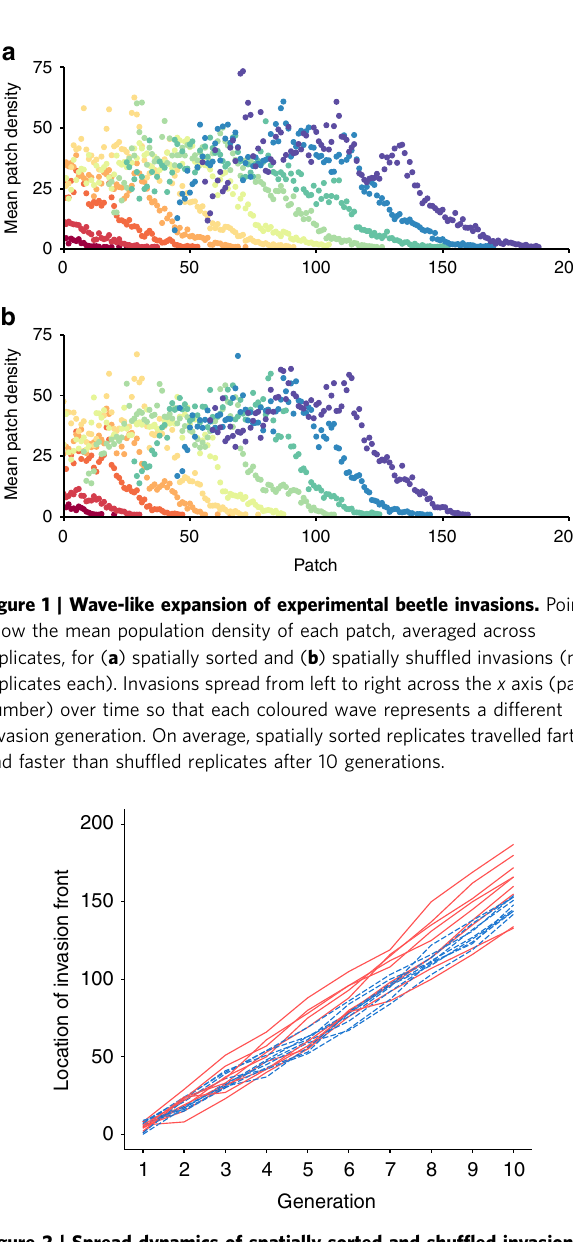
of the mean invasion speed. Thus, the elevated variance was due to unique trajectories of individual invasion replicates and not inconsistency in speed from one generation to the next. In fact, while most spatially sorted replicates were faster than most shuffled replicates, the two slowest replicates were spatially sorted (Fig. 2).